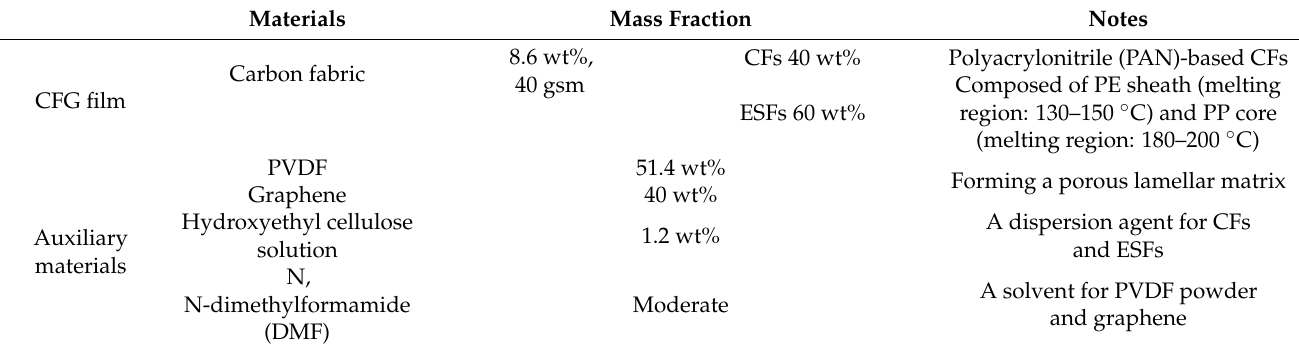
Table 1. Materials used and related parameters in this